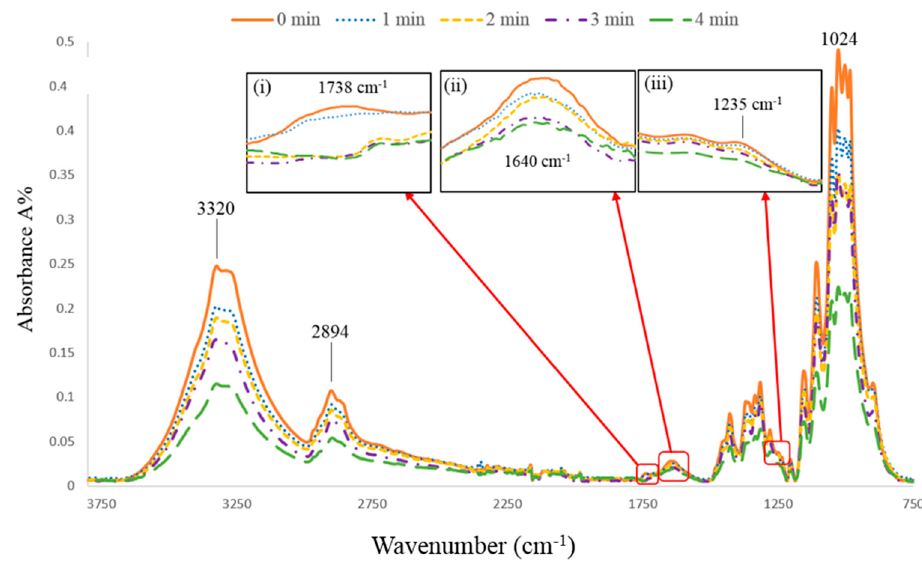
Figure 6. ATR-FTIR spectra of untreated and plasma treated ramie fibers at with enlarge sections of